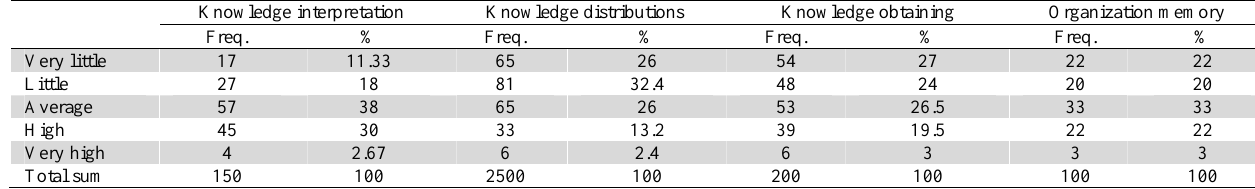
Description of frequency percent of answers to dependent variables Knowledge